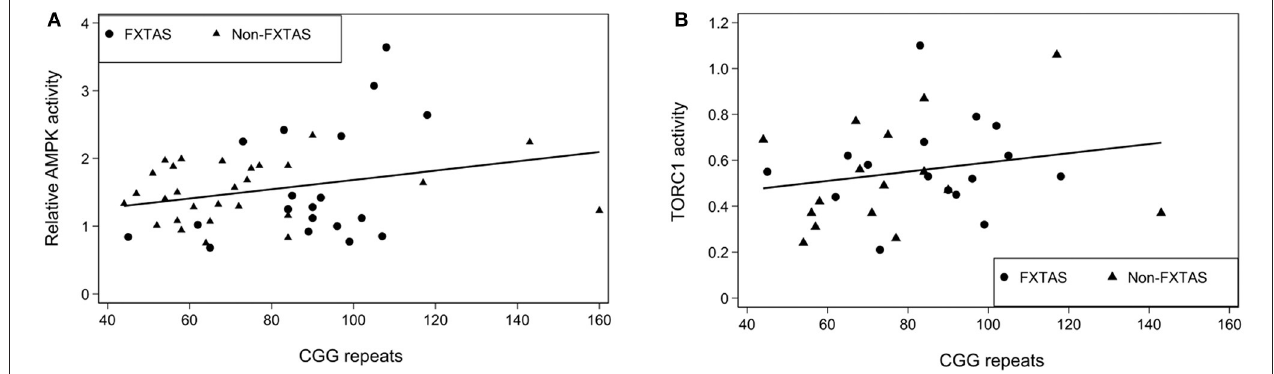
FIGURE 2 | Scatterplots representing the linear relationship between relative AMPK activity (A) and TORC1 levels (B) in the total sample of PM carriers. Regression of AMPK on CGG: coefficient, 0.0052, p = 0.181; regression of TORC1 on CGG: coefficient, 0.0015, p =